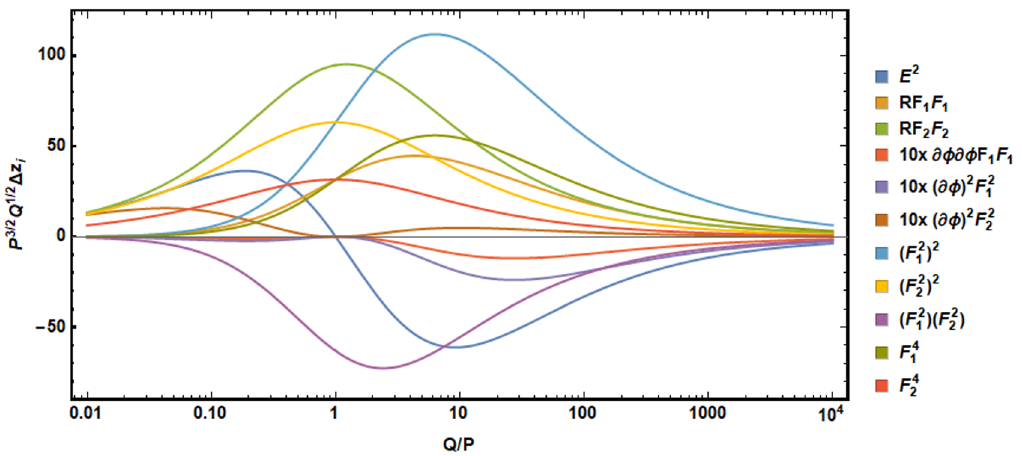
Figure 2 . (Rescaled) individual contributions ∆ z i to ∆ z α and ∆ z β